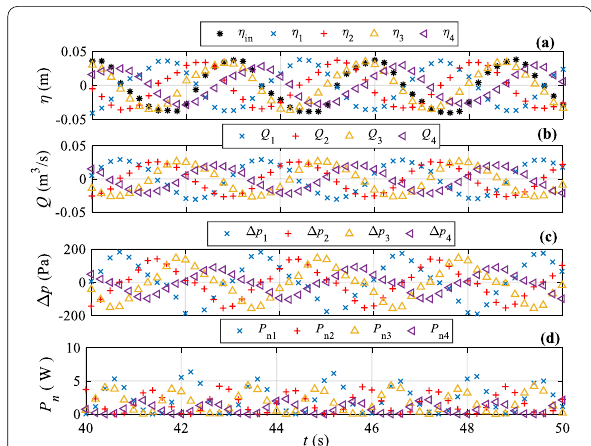
Figure 5 Sample of time-series data of ( a ) water surface elevation η , ( b ) airflow rate through the orifice Q , ( c ) differential air pressure ∆ p , ( d ) pneumatic power P n in each chamber for a wave condition of H 100 mm, T 1.5 s, a draught d 250 mm and an orifice of D = = =